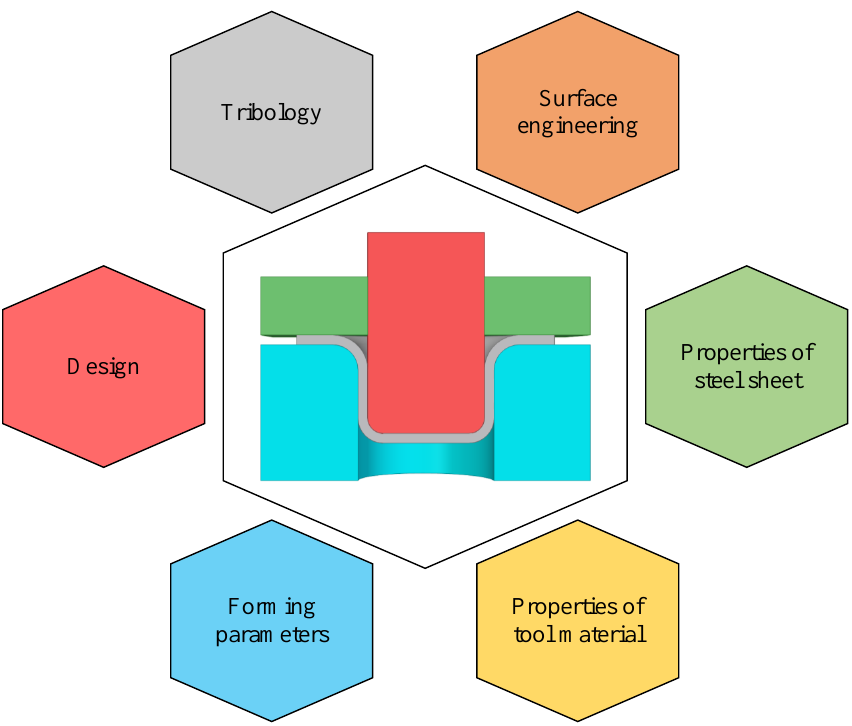
Figure 1. Factors influencing sheet metal formability.